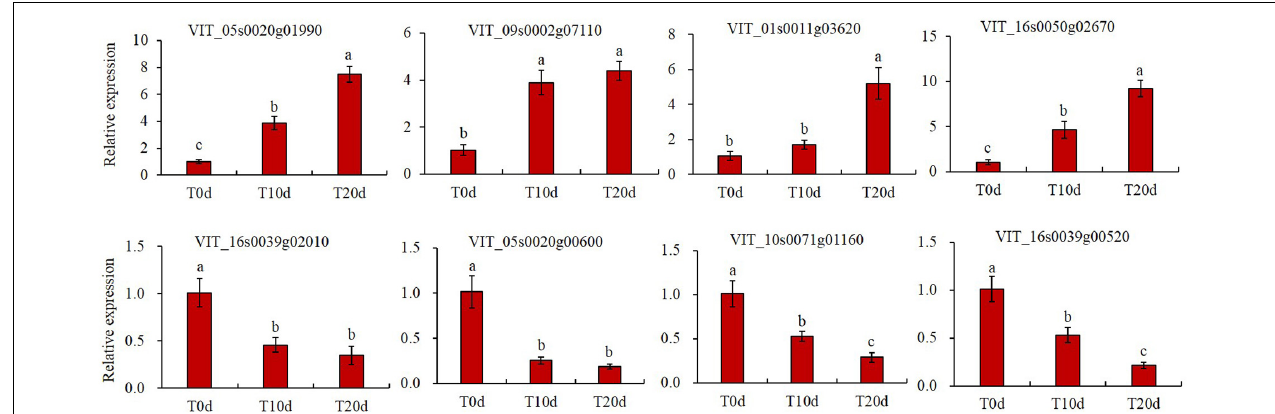
FIGURE 10 | Validation of TMT data by qRT-PCR. The grapevine actin gene (AB073011) was used as an internal control. Three independent experiments were conducted for at least three biological replicates each. The error bars represent the means ± standard deviation (SDs). Columns with the same letter were not significantly different at p <